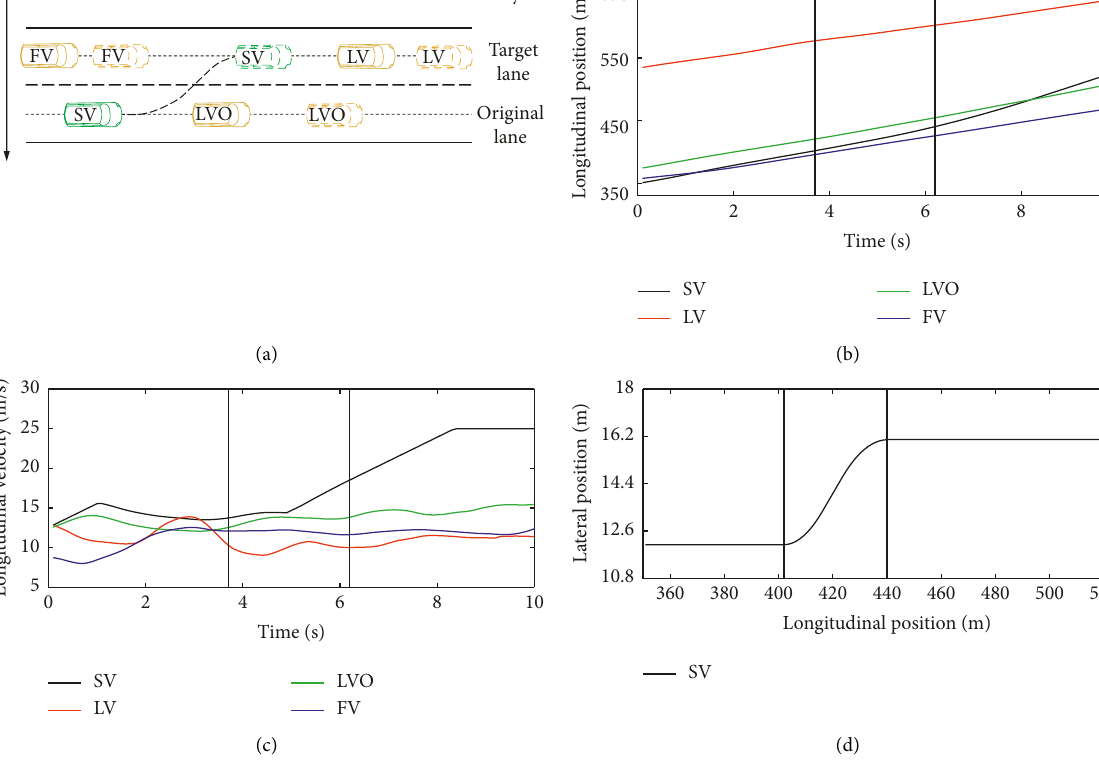
Figure 12: #2 sampled lane-changing scenario. (a) Initial and final state. (b) Plot of longitudinal position with respect to time. (c) Plot of longitudinal velocity with respect to time. (d) Lane-changing trajectory.